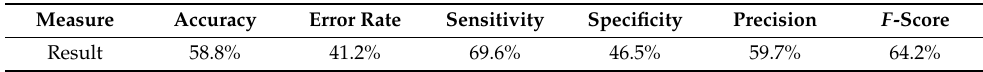
Table 6. Evaluation measures for the SDS over the 1500